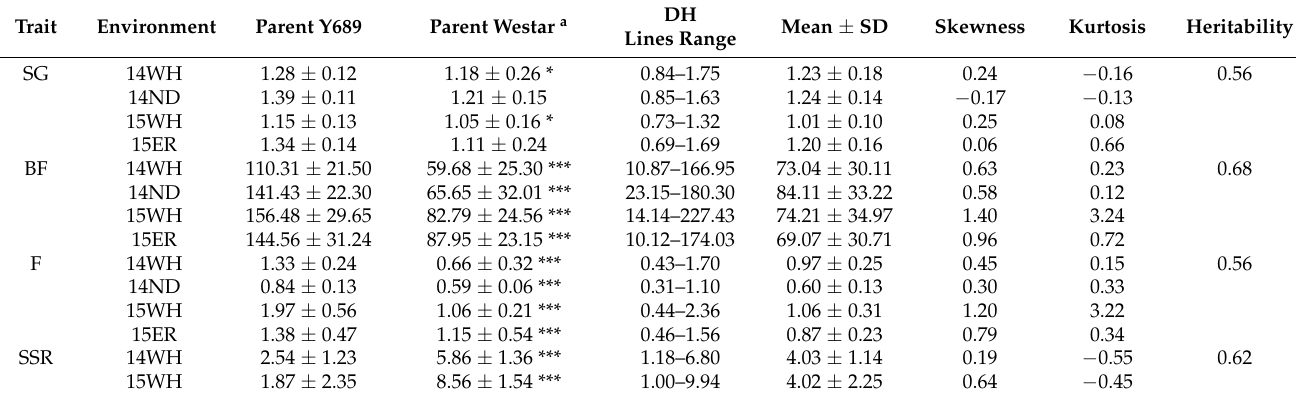
Figure 3. Phenotypic distributions of ADL, Cel, Hem, SG, BF, F and SSR in the YW-DH population derived from the cross ‘Y689 ′ × ‘Westar’. ( a ) Acid detergent lignin content, ( b ) cellulose content, ( c ) hemicellulose content, ( d ) syringyl/guaiacyl monolignol ratio, ( e ) breaking force, ( f ) breaking strength and ( g ) resistance against Sclerotinia sclerotiorum . 14WH, 14ND, 15WH and 15ER repre- sent four environments with different colors. 14WH: Wuhan, 2014–2015; 14ND: Weinan, 2014– 2015; 15WH, Wuhan, 2015–2016; 15ER, Ezhou, 2015–2016.